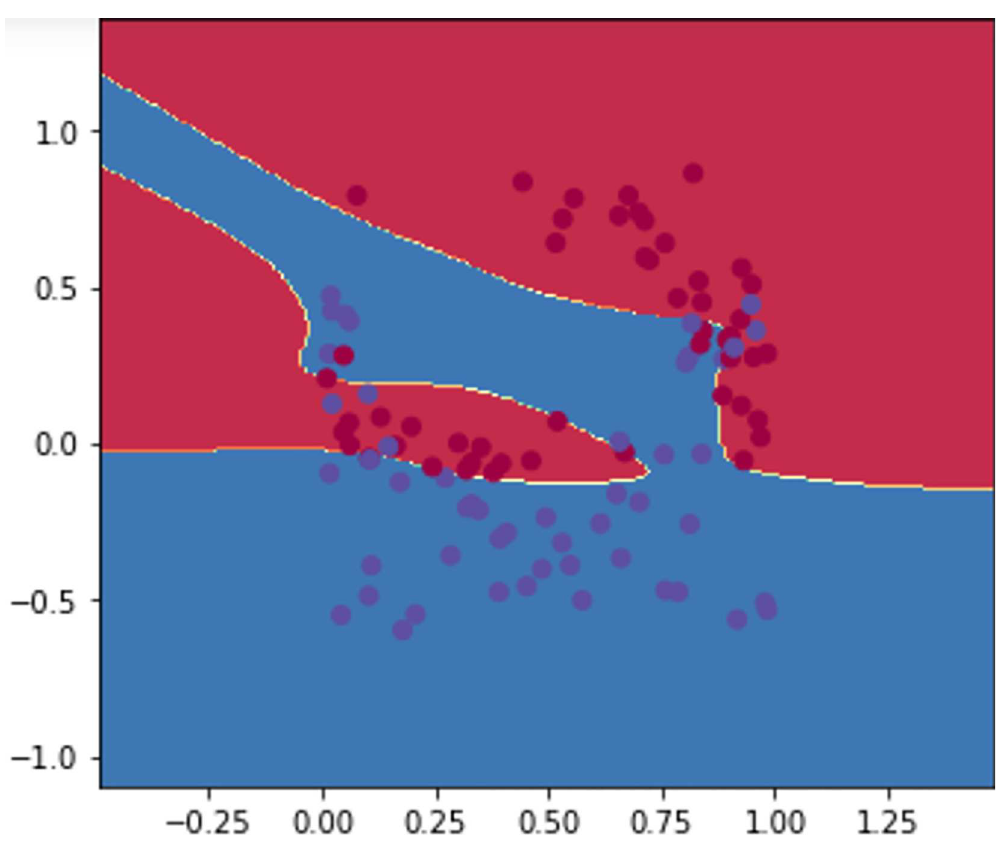
Fig 32. Decision boundary after edge